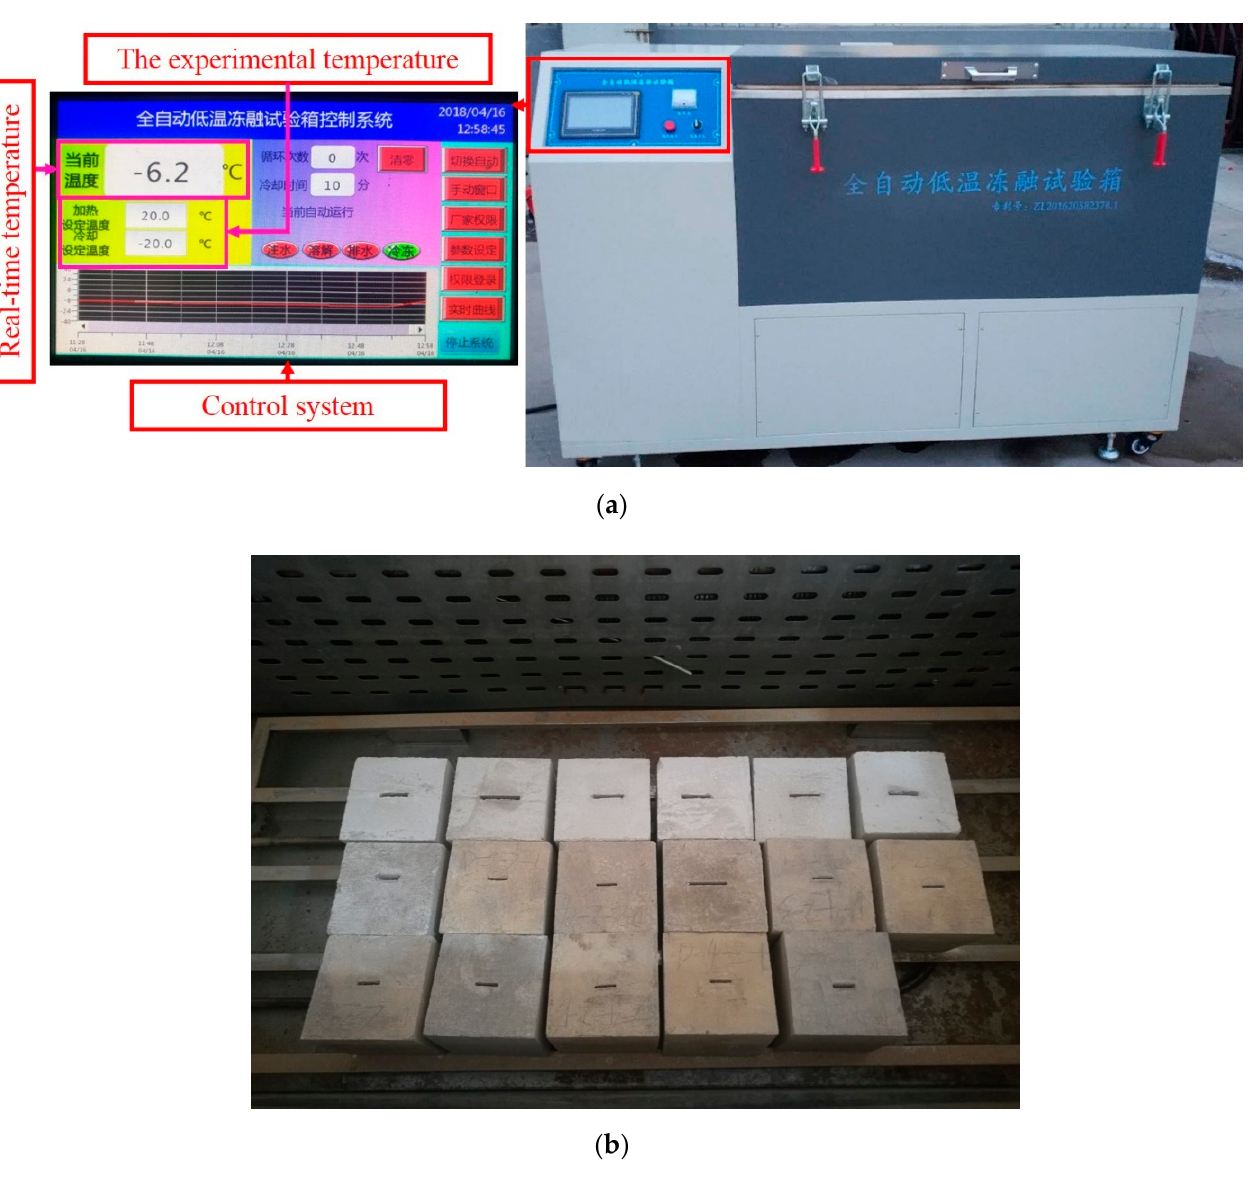
Figure 2. Freeze-thaw cycle experiment equipment and process. ( a ) TDS-300 automatic low-temperature freeze-thaw experiment container. ( b ) Specimens during the freeze-thaw experiment.